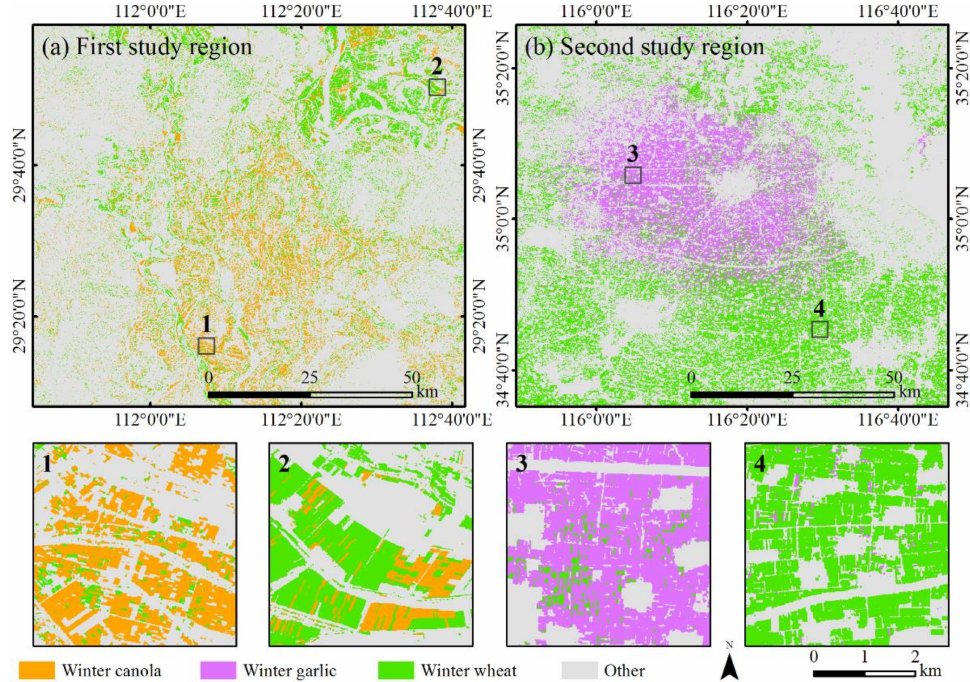
Figure 5. Maps of winter canola, winter garlic and winter wheat in the ( a ) first and ( b ) second study